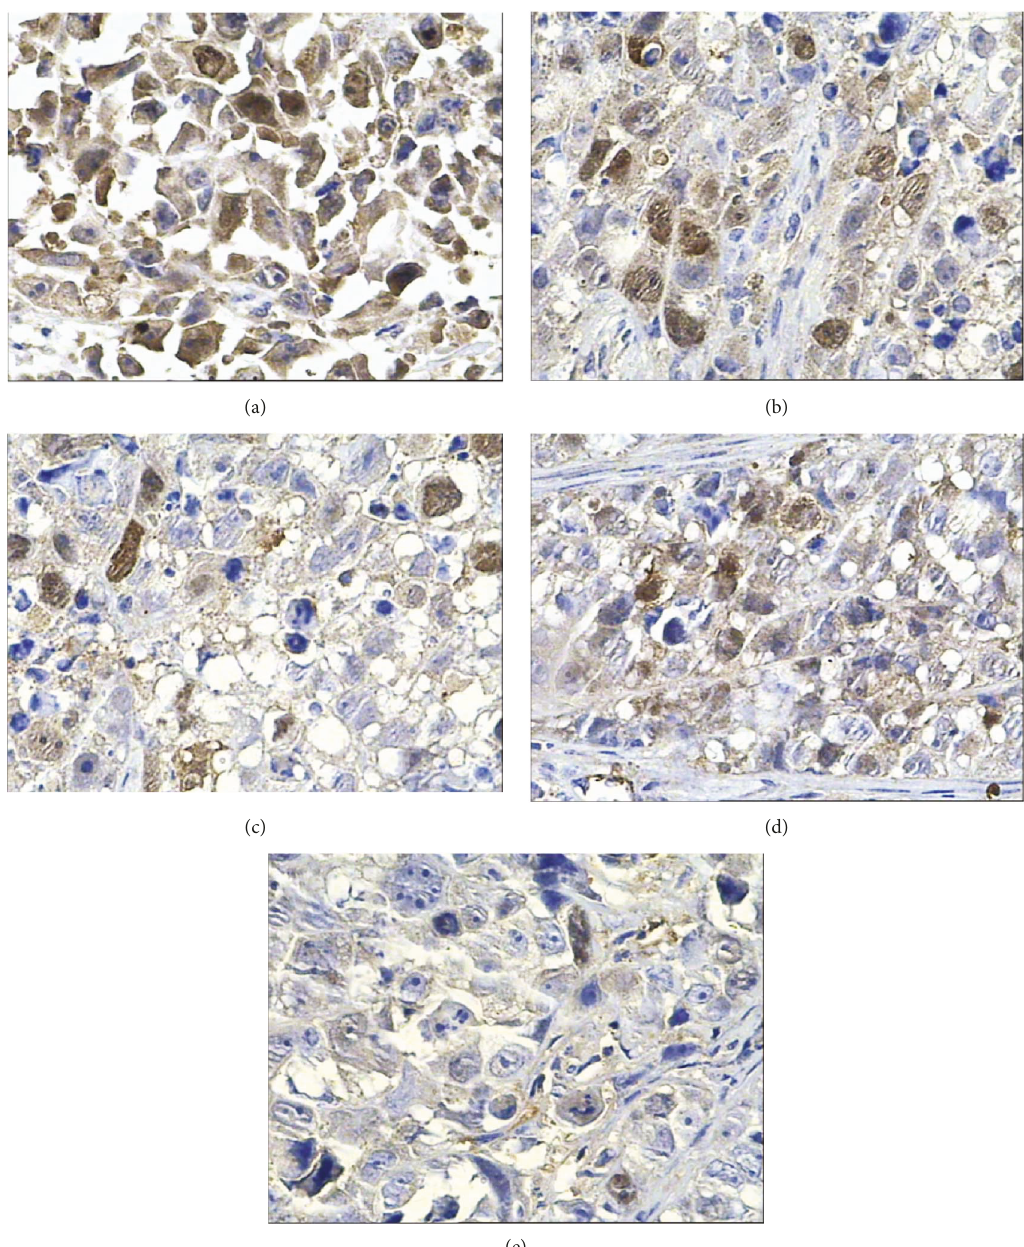
Figure 2: Survivin protein expression in hepatoma tissues after di ff erent treatments tested by IHC (400x). (a) Saline control group. (b) Radionuclide group. (c) Radionuclide-gene group. (d) MFH group. (e) Radionuclide-gene-MFH